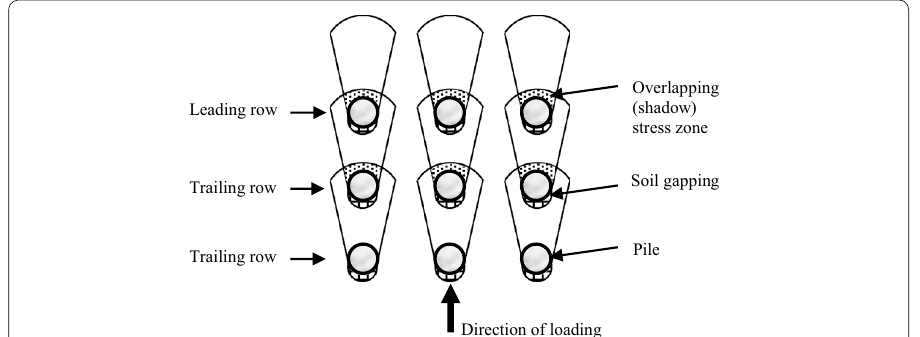
Fig. 1 Illustrated of reduction in lateral pile resistance due to pile‑pile interface (Reproduced with permission from Rollins et al. [27] and Ashour et al. [1])